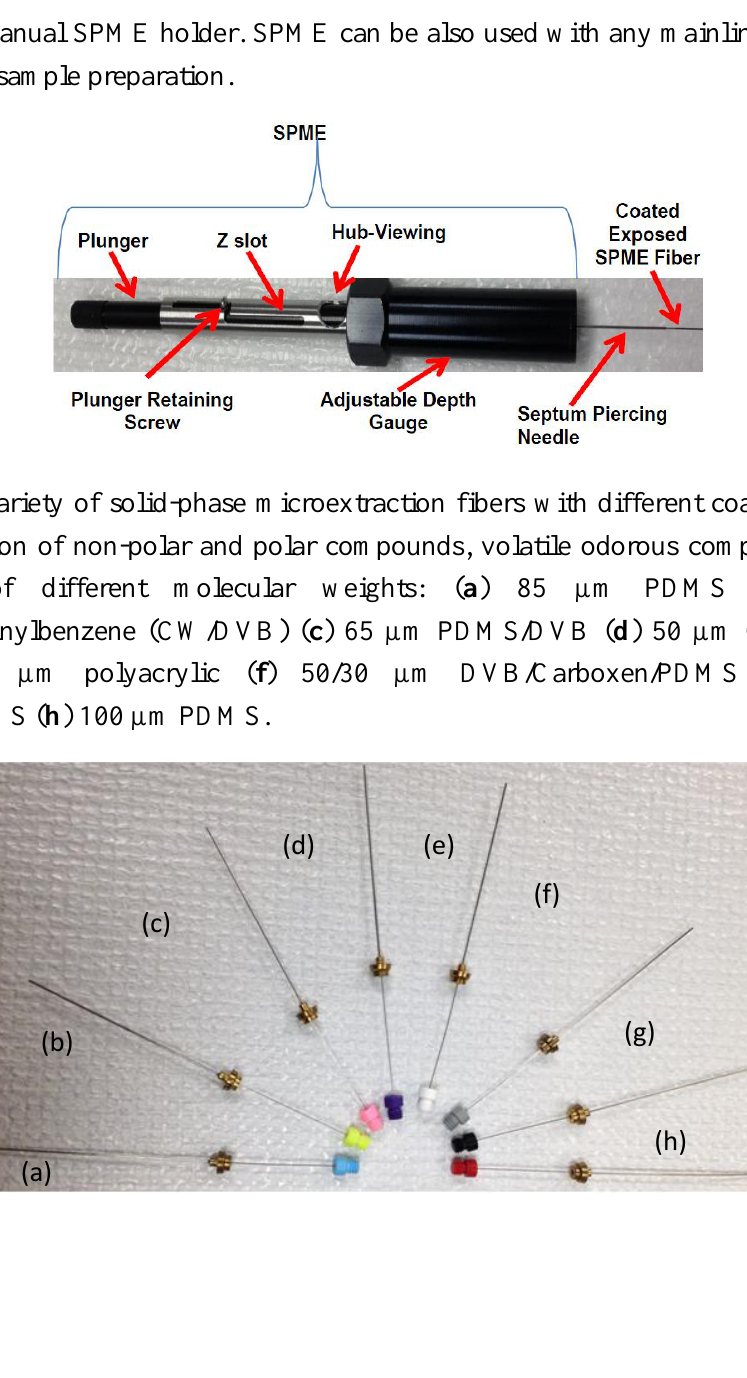
Figure 2. A manual SPME holder. SPME can be also used with any mainline autosampler for automated sample preparation.